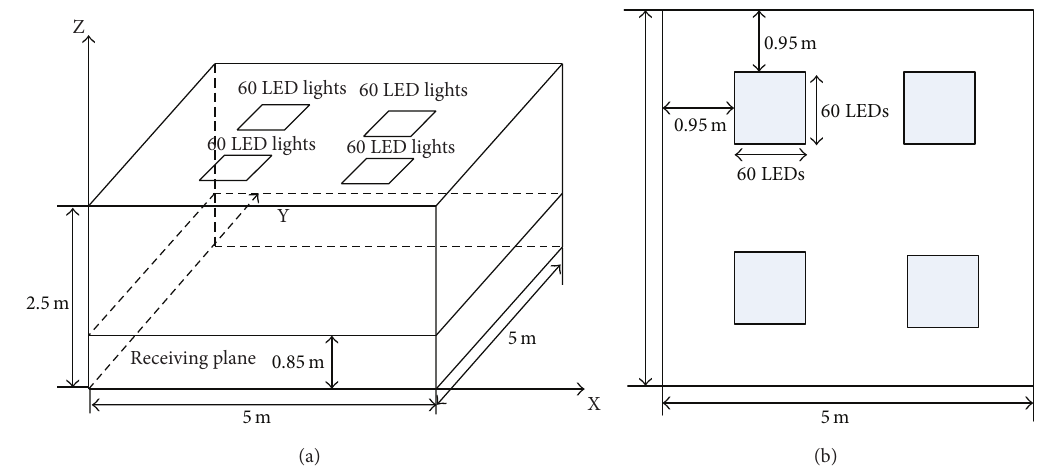
Figure 5: Simulation environment: (a) 3D Schematic and (b) 2D Schematic.